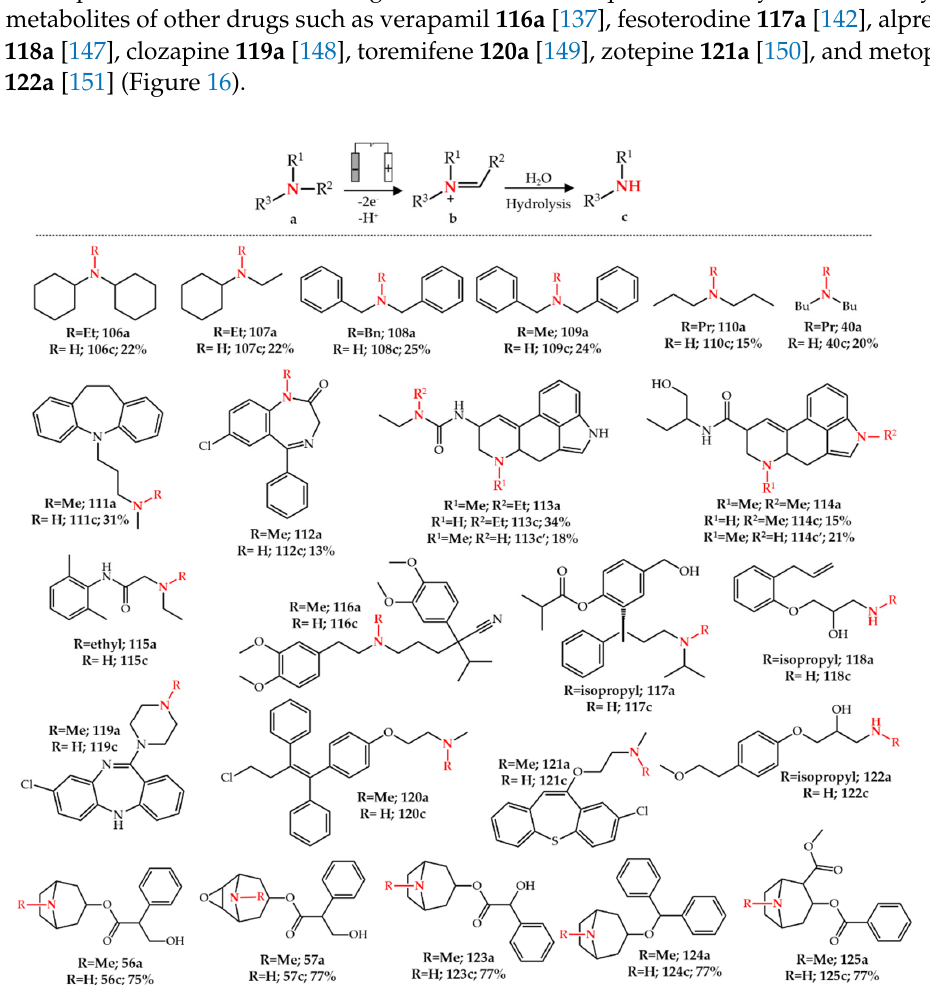
Figure 17. ( A ) Electrochemical oxazolidination and acyl transfer and ( B ) TEMPO ‐ mediated electro ‐ chemical N ‐ demethylation of opiate alkaloids. We recently showed that a TEMPO ‐ mediated electrochemical strategy affords the N ‐ demethylation of opiate alkaloids in one step [12]. This reaction proceeds in 70% aq. ace ‐ tonitrile at room temperature using a two ‐ electrode reactor in which both electrodes were glassy carbon (100 PPI). Different noropiates with and without C14 ‐ hydroxyxl groups ( 3b ,